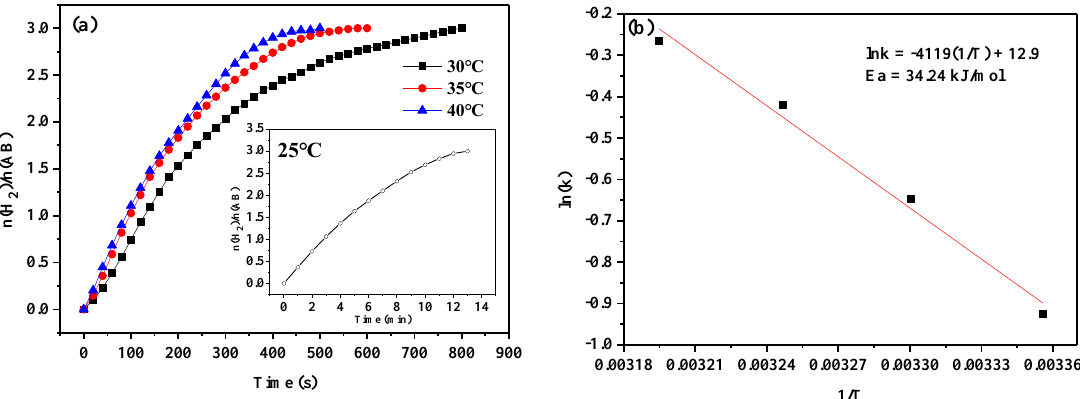
Figure 9. ( a ) Hydrolysis of AB at different temperatures catalyzed by MoO 3 -doped MnCo 2 O 4 (0.10) and ( b ) the corresponding Arrhenius plot of ln(k) vs. (1/T).